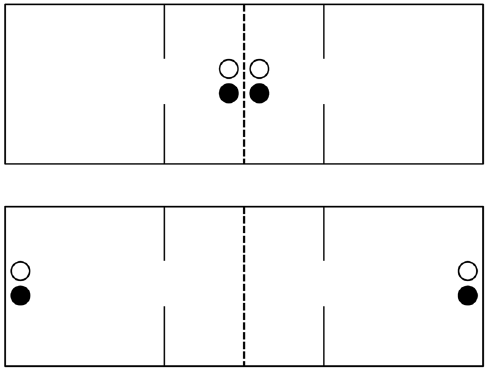
Figure 1. Drinking apparatus. ‘Bird’s eye view’ schematic of the drinking apparatus in the social drinking condition (top) and non-social drinking condition (bottom). Solid lines indicate cage walls, dashed lines indicate the wire divider, and circles indicate drinking tubes. Clear circles represent water; black circles represent 10% alcohol in water.